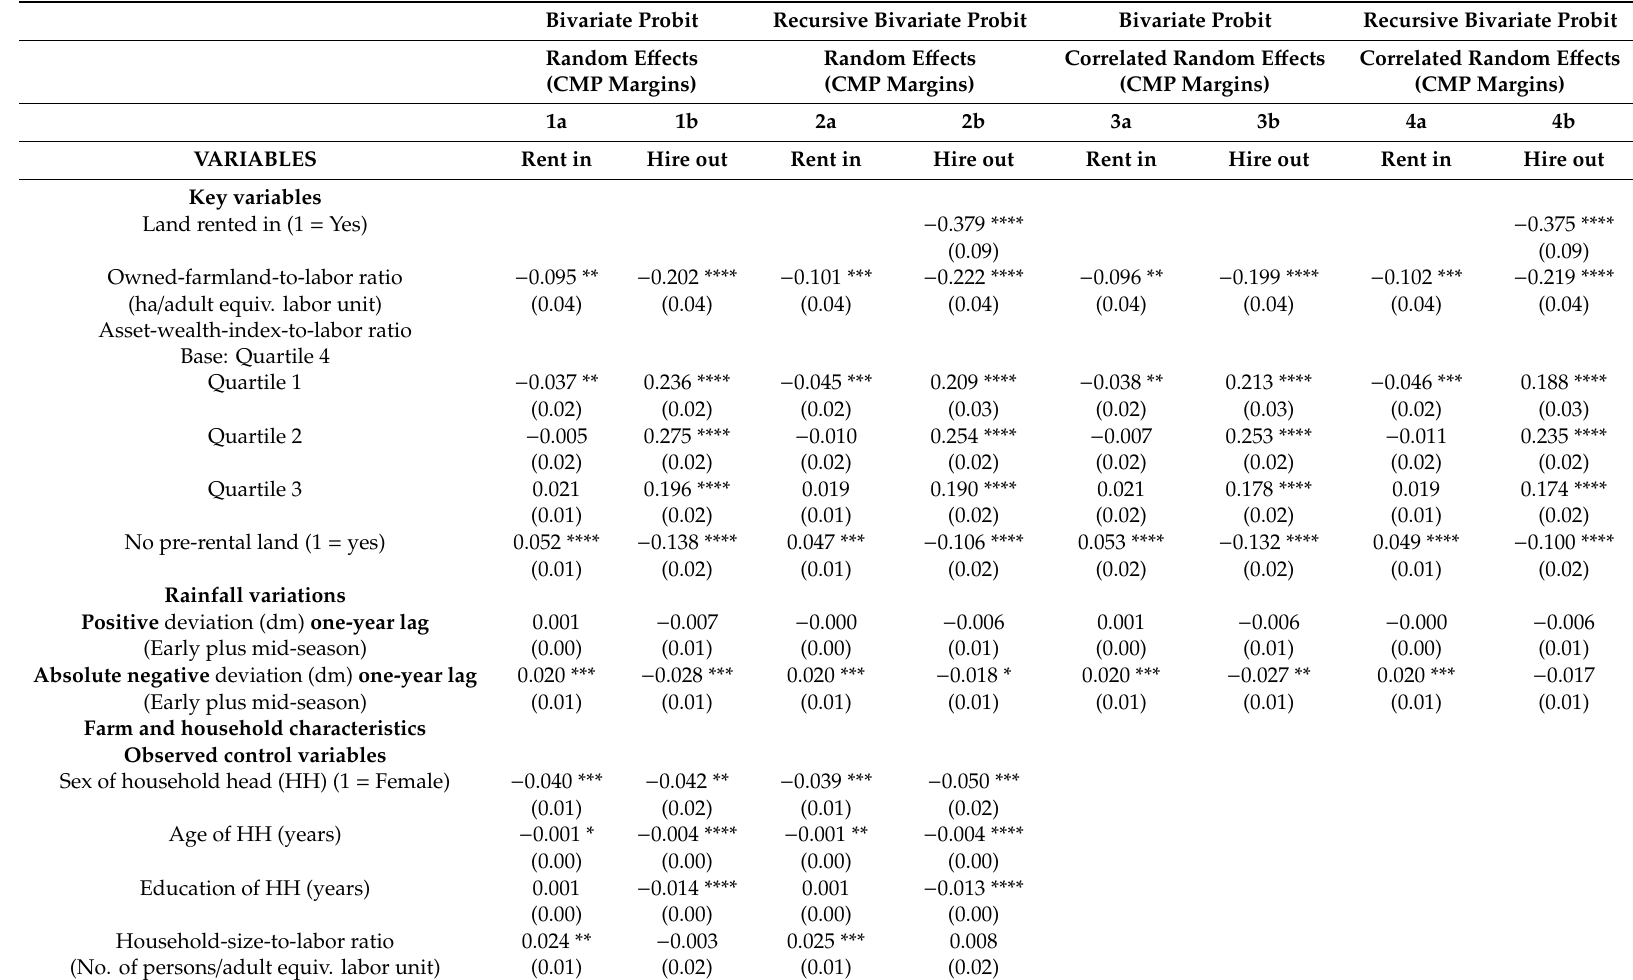
Table A2. Bivariate probit model with conditional mixed process (CMP) margins for land rental and casual labor ( ganyu ) market